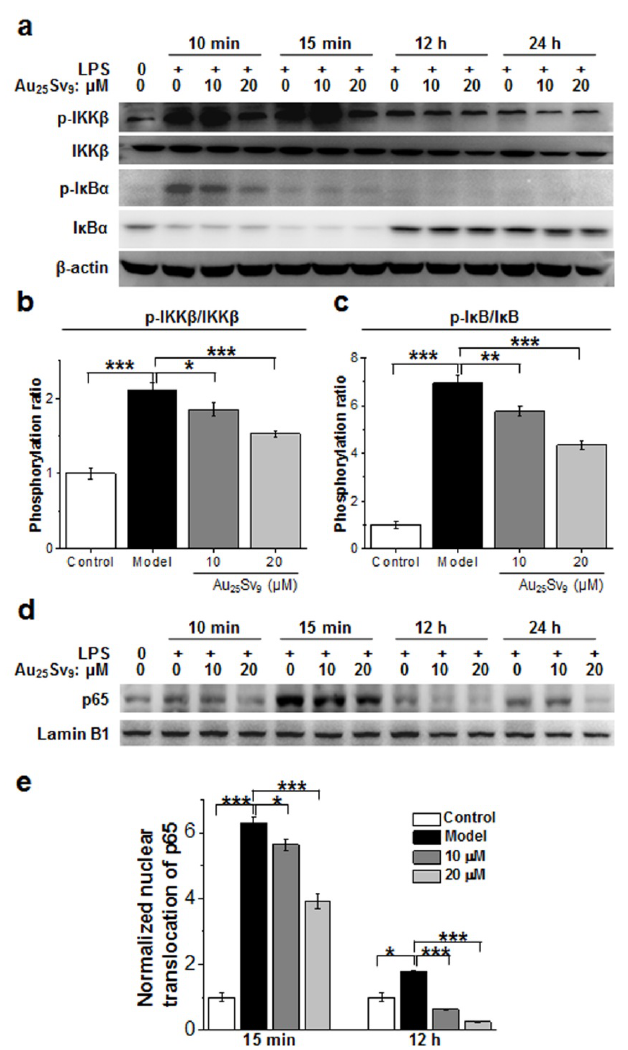
Figure 4. The inhibitory effect of Au 25 Sv 9 on NF- κ B (nuclear factor kappa B) pathway activation in LPS (lipopolysaccharide)-stimulated HBZY-1 cells. ( a ) Western blotting detection of the expression and phosphorylation of IKK β (I κ B kinase beta) and I κ B α (NF- κ B inhibitor alpha) in cytoplasm after incubation with LPS and Au 25 Sv 9 for different times. β -actin was used as the loading control. ( b ) The relative phosphorylation ratio of IKK β (p-IKK β / IKK β ) at 10 min was densitometry-analyzed. Data was expressed as the mean ± standard deviation (n = 3). ( c ) The relative phosphorylation ratio of I κ B α (p-I κ B α / I κ B α ) at 10 min was densitometry-analyzed. Data was expressed as the mean ± standard deviation (n = 3). ( d ) Western blotting detection of NF- κ B (p65) in the nucleus of HBZY-1 cells after incubation with LPS and Au 25 Sv 9 for different times. Lamin B1 was used as the loading control. ( e ) The relative nuclear translocation of p65 at 15 min was densitometry-analyzed. Lamin B1 was used to normalize the data. Data was expressed as the mean ± standard deviation (n = 3). *P < 0.05, **P < 0.01, ***P < 0.001.